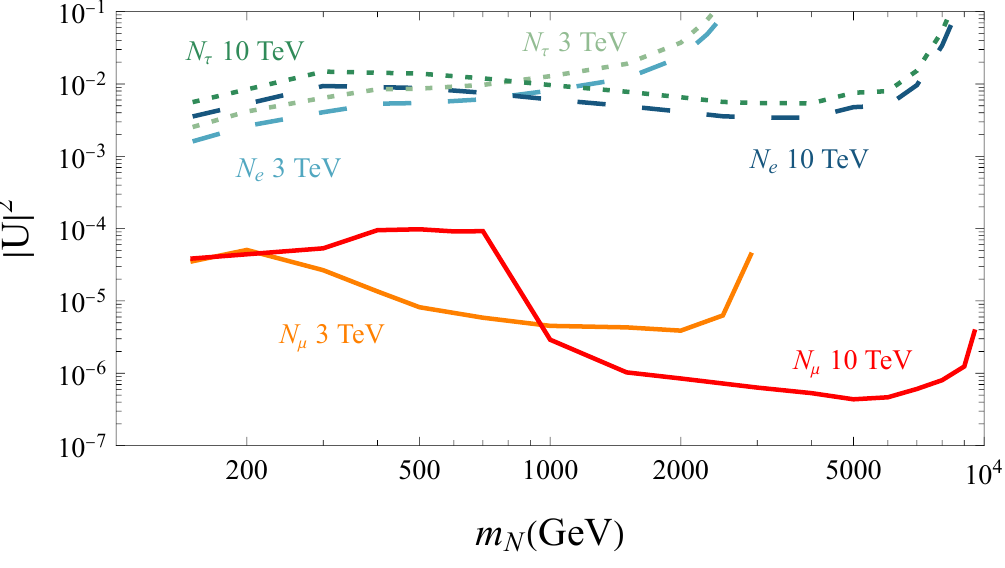
Figure 9 . The 95% projected sensitivity of | U µ | 2 , | U e | 2 and | U τ | 2 as a function of HNL mass m N at 3 and 10 TeV muon collider.